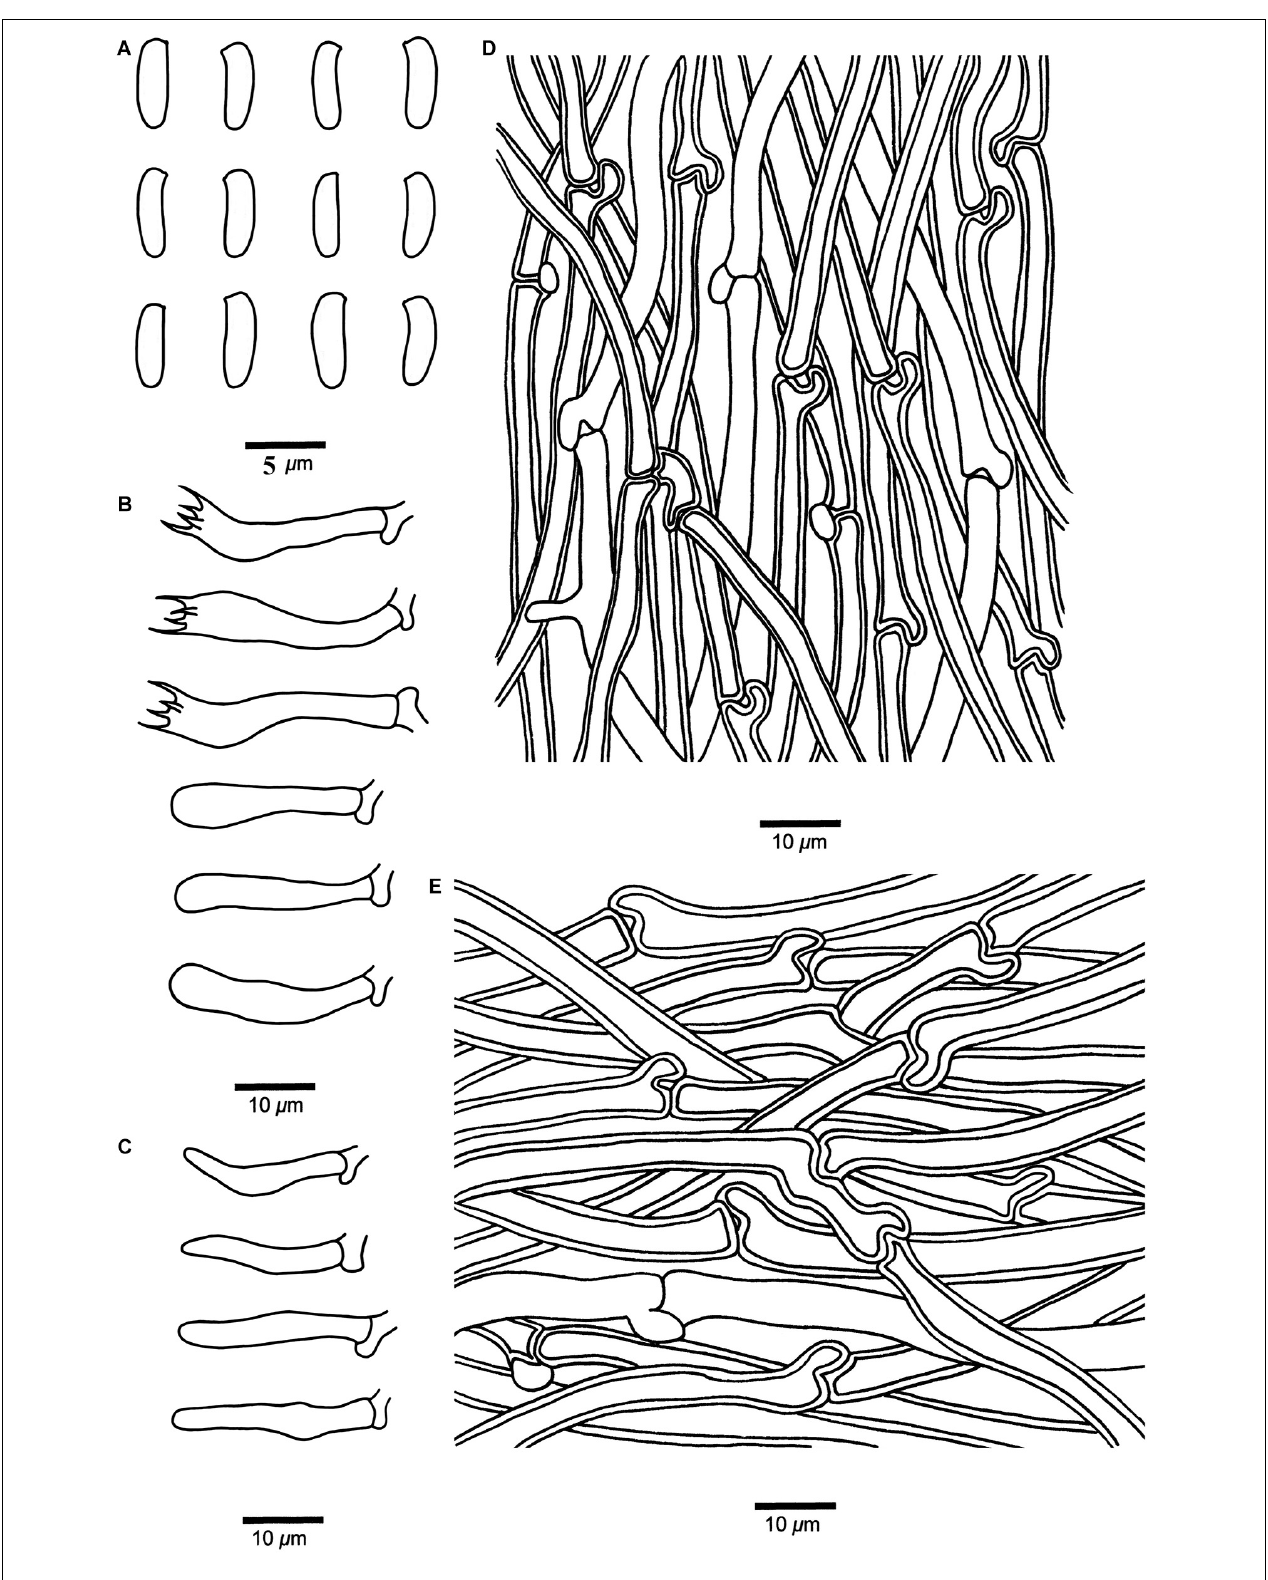
FIGURE 9 | Microscopic structures of Cyanosporus tenuis (drawn from the holotype). (A) Basidiospores; (B) Basidia and basidioles; (C) Cystidioles; (D) Hyphae from trama; (E) Hyphae from context. Bars: (A) = 5 µ m; (B–E) = 10 µ m.